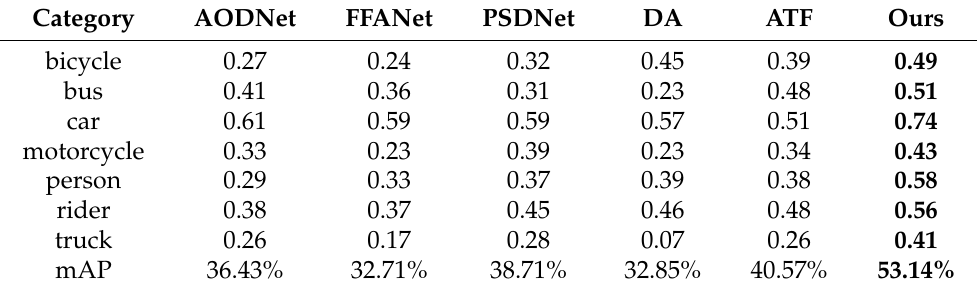
Figure 8. Results comparison of Foggy Cityscapes with sparse fog between JSFU , combination methods including AODNet+Faster RCNN , FFANet + Faster RCNN , PSDNet + Faster RCNN , and domain adaptive methods including DA and ATF (electronic zoom-in recommended). Table 2. Comparison of AP and mAP between JSFR , combination methods including AODNet+Faster RCNN , FFANet + Faster RCNN , PSDNet + Faster RCNN , and domain adaptive methods including DA and ATF